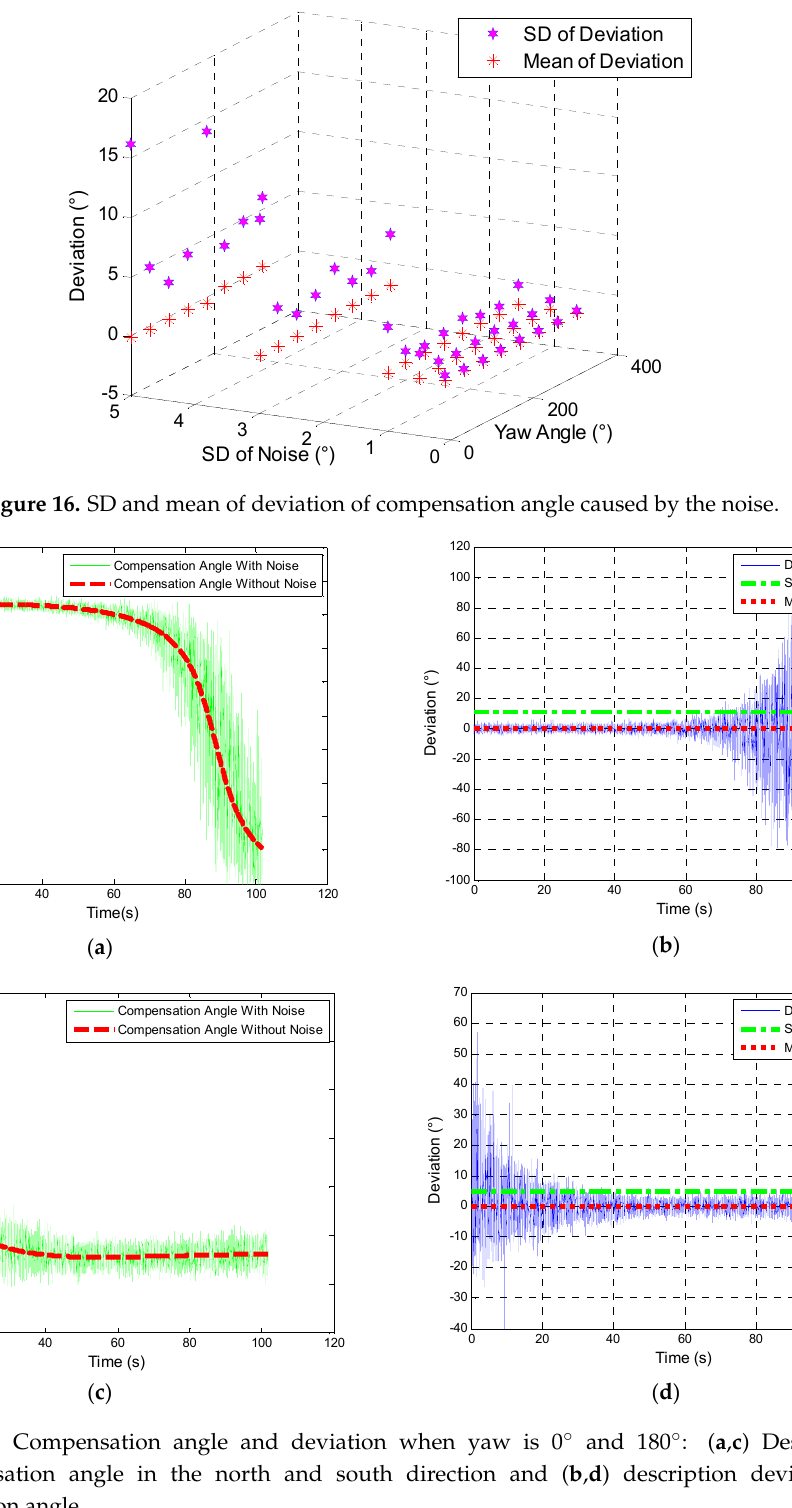
Figure 17. Compensation angle and deviation when yaw is 0° and 180°: ( a , c ) Description of compensation angle in the north and south direction and ( b , d ) description deviation of compensation angle.